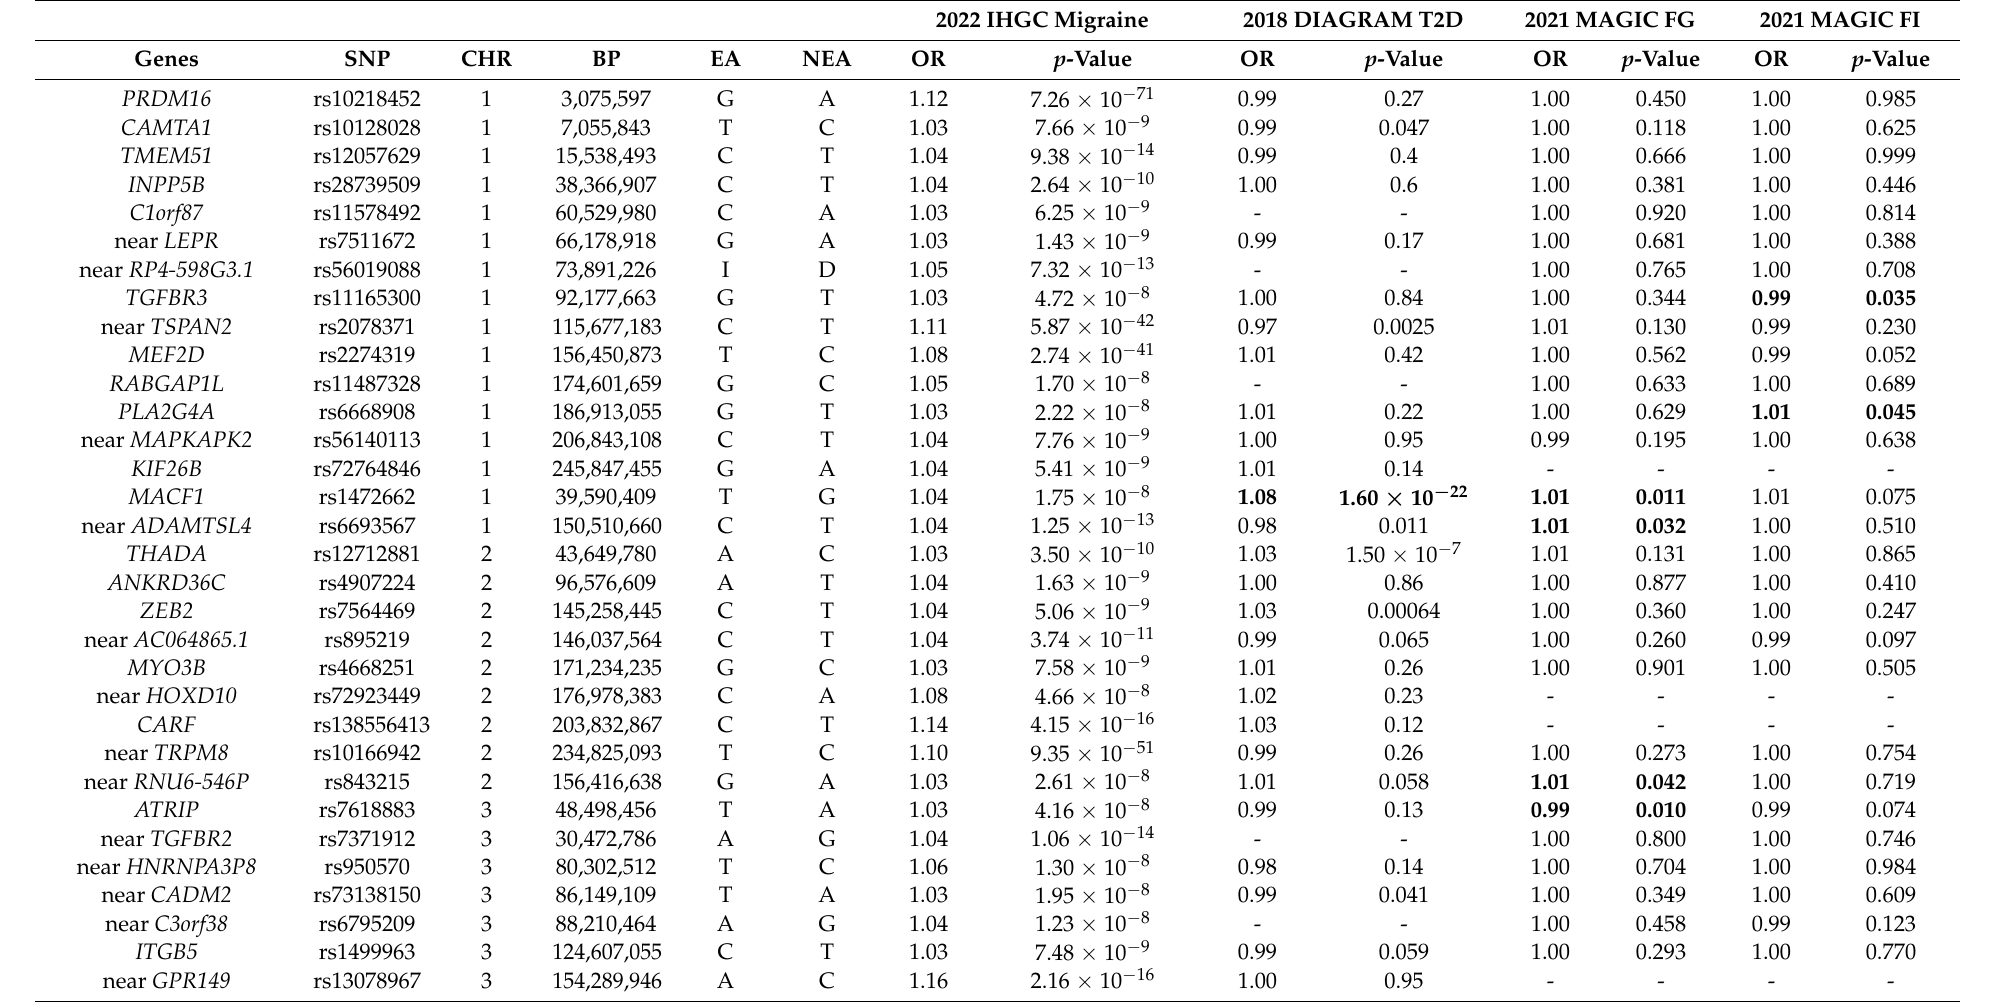
Table 2. Genome-wide significant migraine risk loci and their associations with FG, FI, and